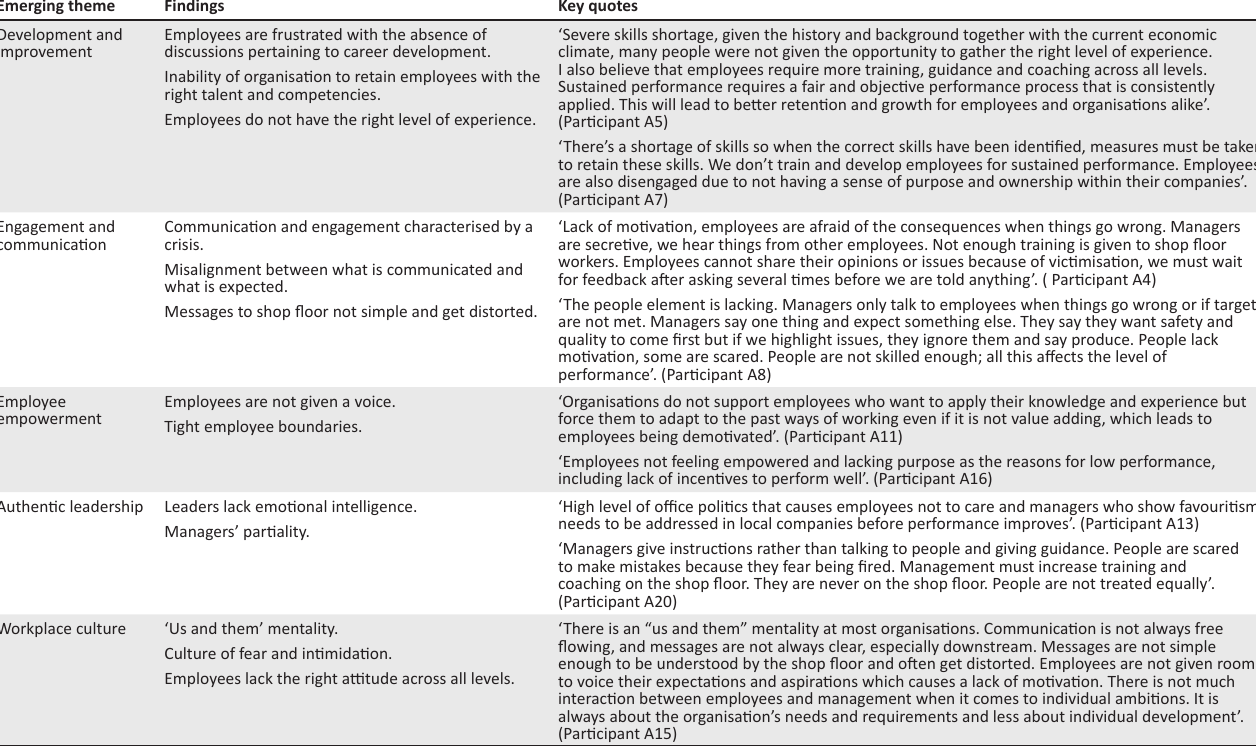
TABLE 4: Summary of findings for question 3 – Performance management. What is the common reason for the level of performance in South African companies? Emerging theme